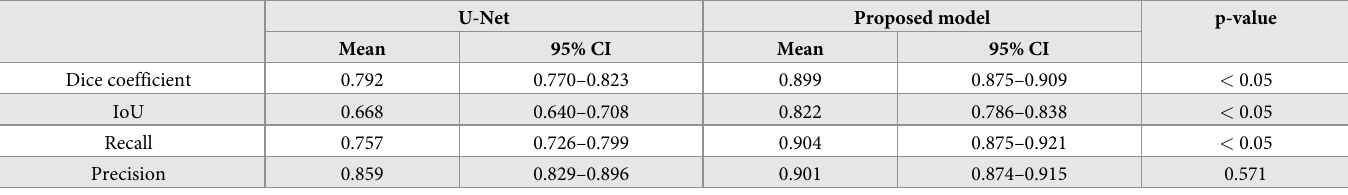
Table 2. Mann-Whitney U test results between U-Net and the proposed model.